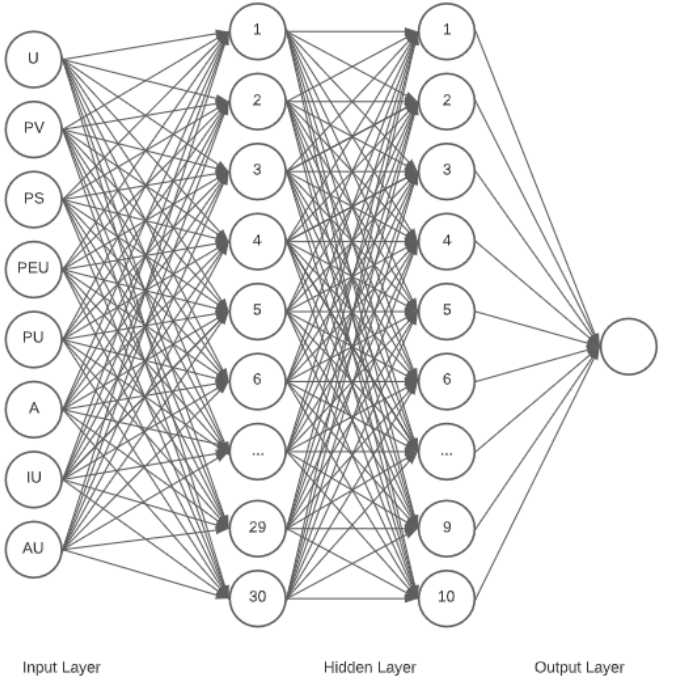
Figure 5. Optimum Deep Learning Neural Network structure for Perceived Usability of Thai Chana COVID-19 Tracing Application.